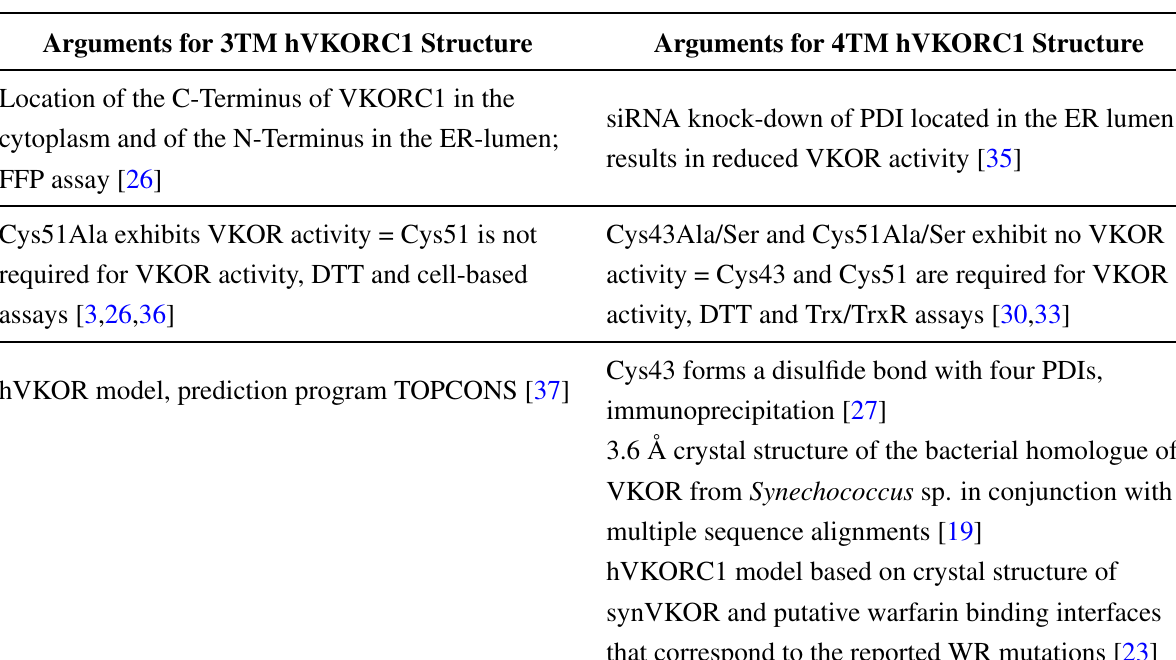
Table 2. Overview of published experimental data supporting 3TM or 4TM topological models for